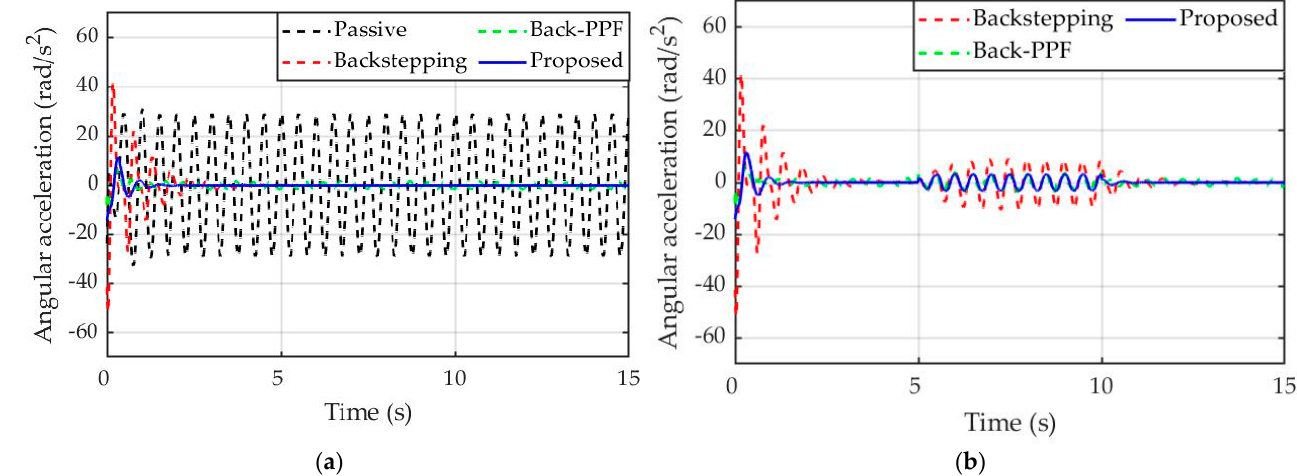
Figure 5. Sprung mass vertical acceleration: ( a ) Non-fault; ( b ) Actuator-fault.